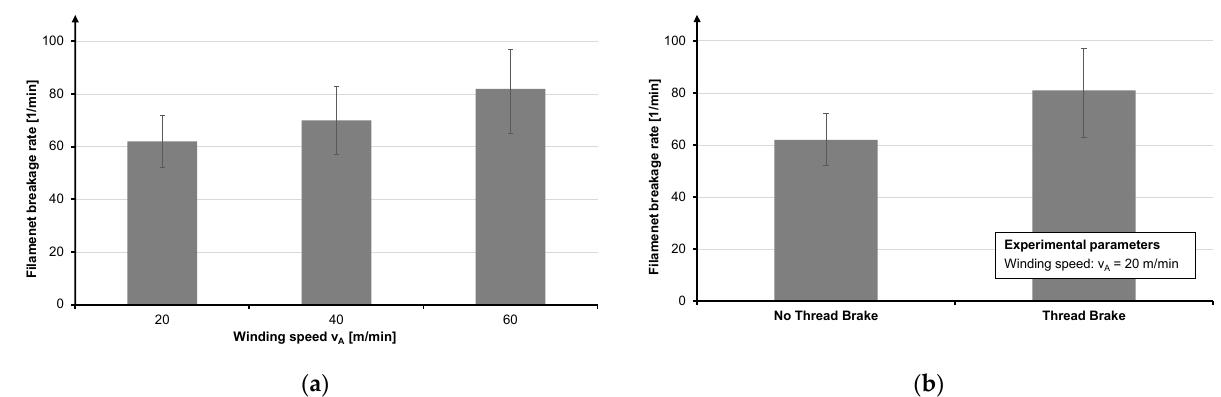
Figure 3. Influence of winding speed ( a ) and yarn brake ( b ) on filament damage.